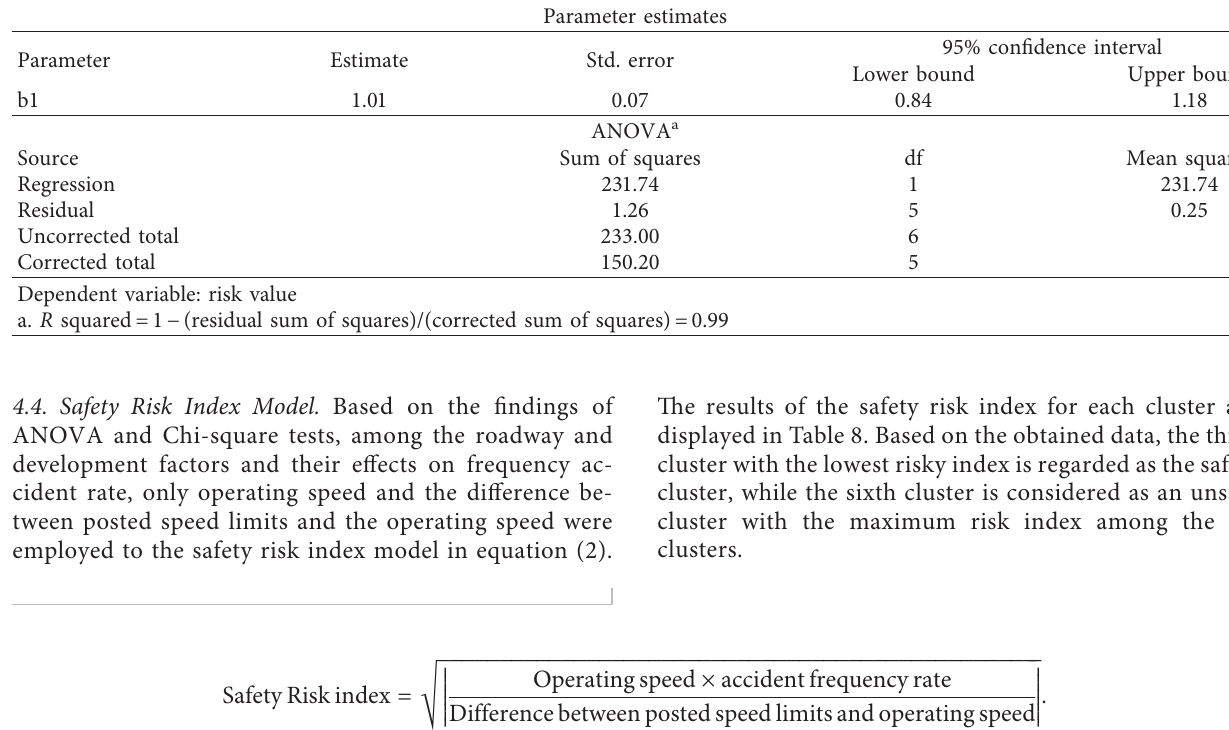
Table 8: ANOVA test for the proposed safety risk